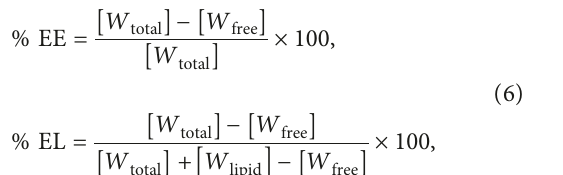
Table 4: Antioxidant activities of green robusta coffee bean extracts detected by DPPH assay, lipid peroxidation inhibitory assay, and FRAP